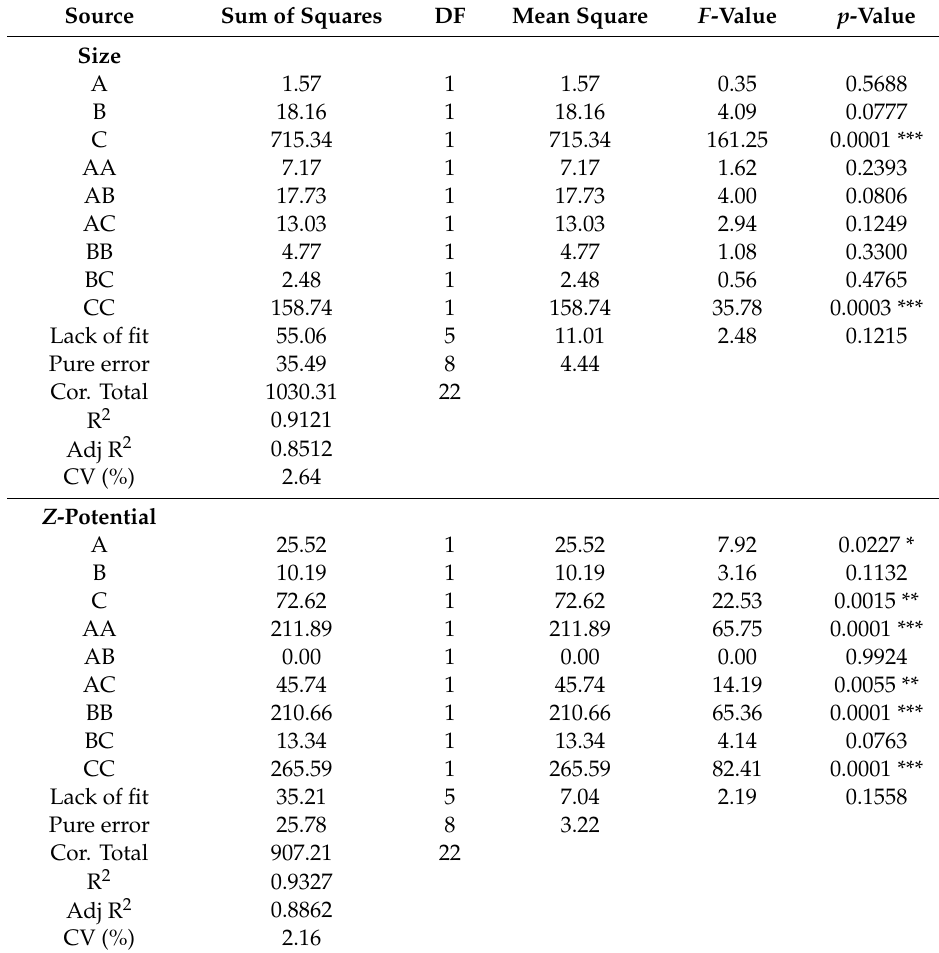
Table 3. ANOVA results for response surface quadratic models in SeNPs